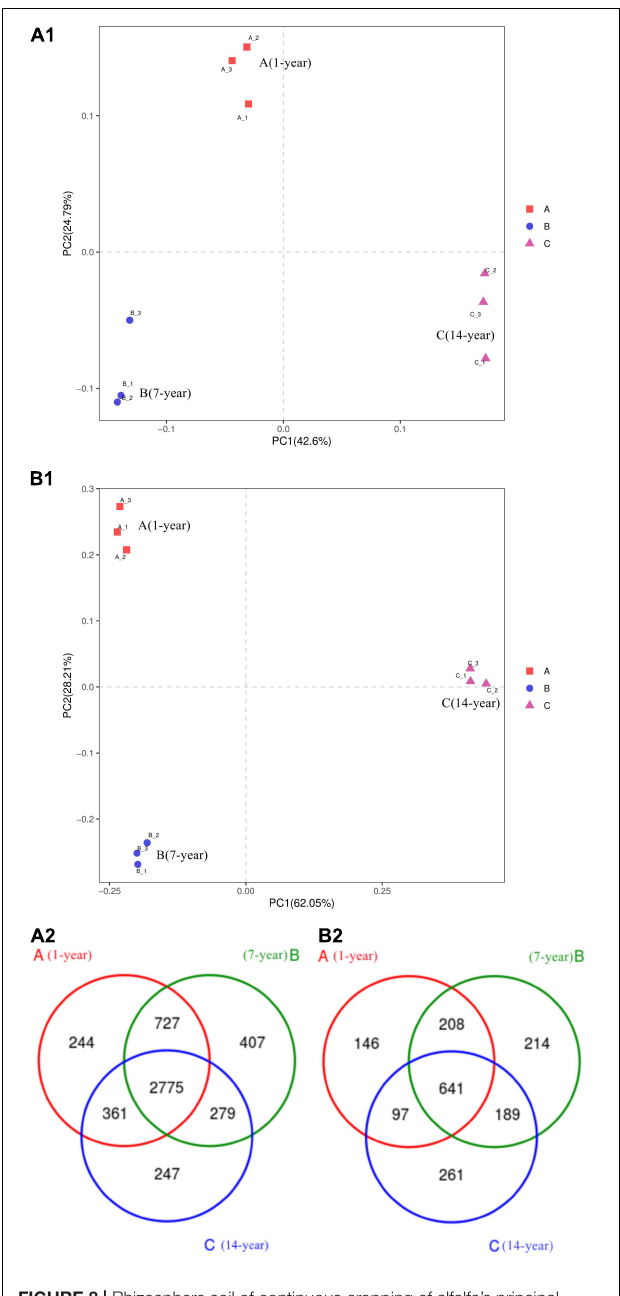
FIGURE 8 | Rhizosphere soil of continuous cropping of alfalfa’s principal coordinate analysis (PCoA). (A1) Bacteria and (B1) fungi. (A2) Venn diagram of bacteria and (B2) Venn diagram of fungi.